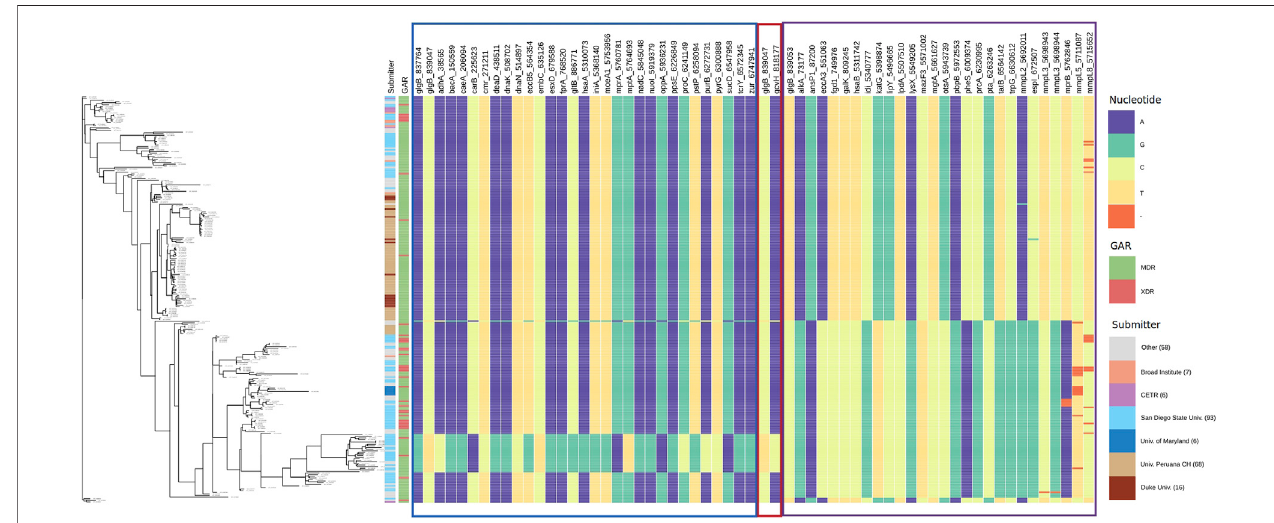
FIGURE6| Alleledistribution at thelociofgenesinteractingwith glgB .Labelsofthecolumnindicategenenameandlocus.Estimated phylogenyisincluded onthe left. Interacting loci are organized in sections with borders. The border color corresponds to the color of the sections in Supplementary Data S7 . GAR = Genotypic Antibiotic Resistance.